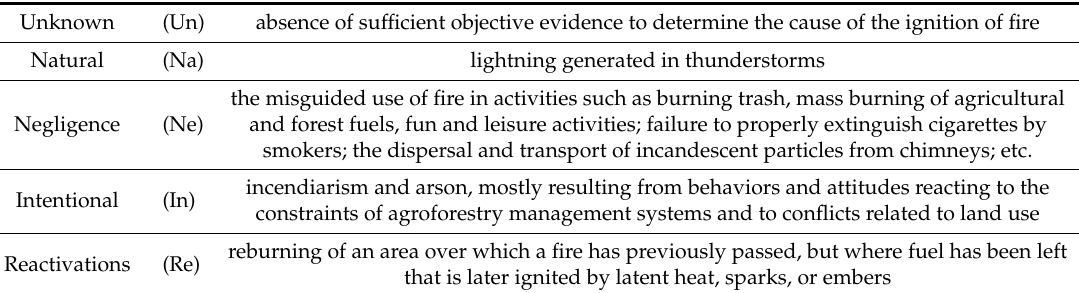
Table 1. Classifications of causes of forest fires.